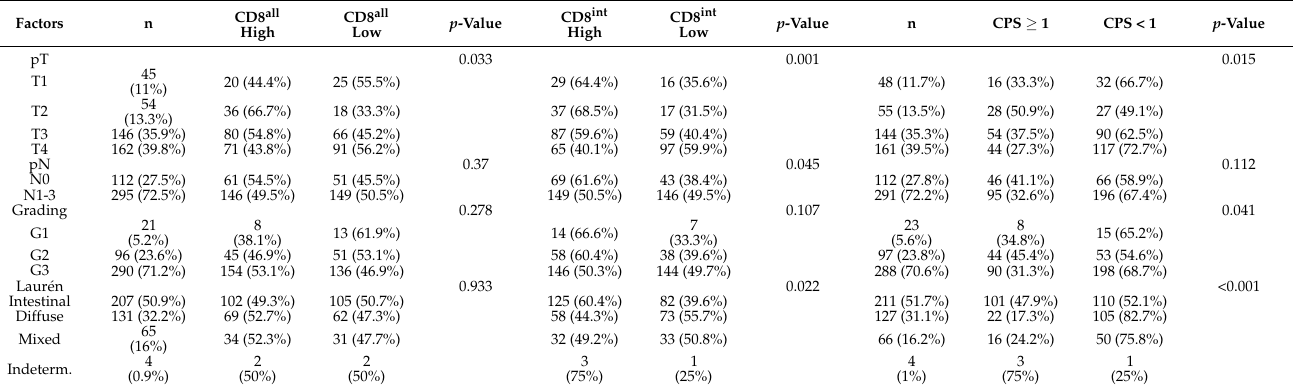
Table 1. Correlations of PD-L1 and CD8 status with clinicopathological parameters.